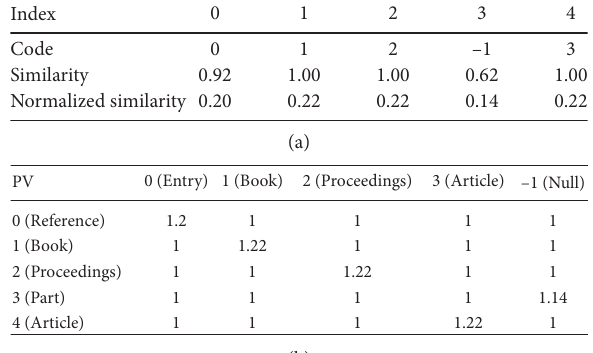
Figure 6: An example of update